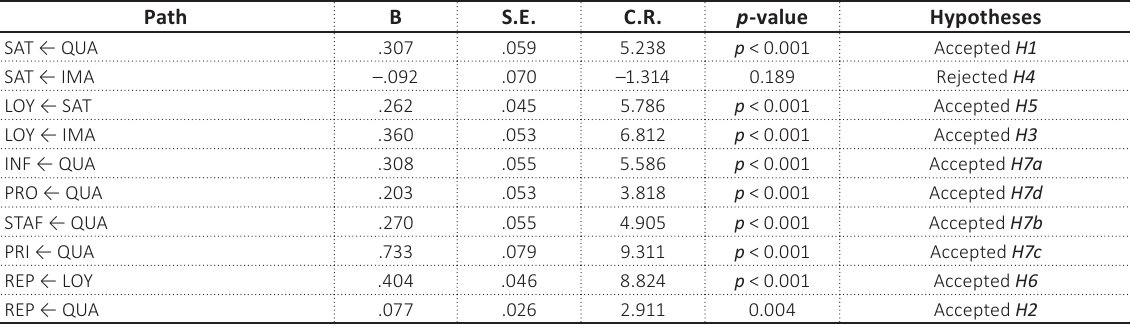
Table 5. Hypotheses